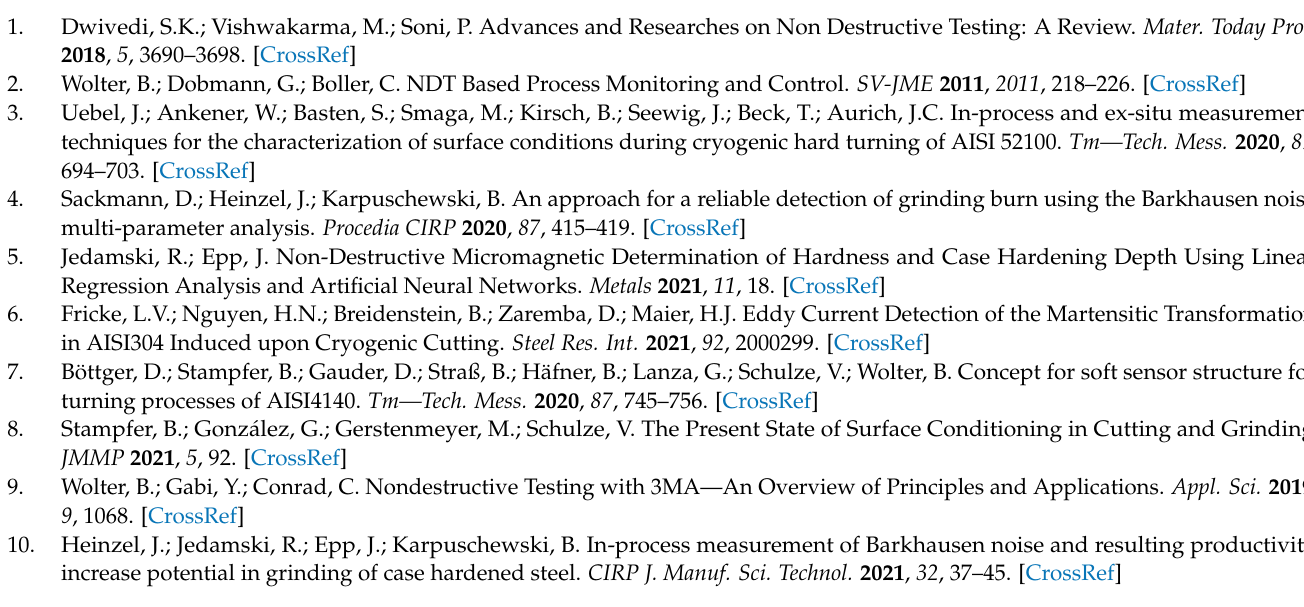
Figure A1. XRD diffractograms of the subjected specimens in their respective groups for better comparability.